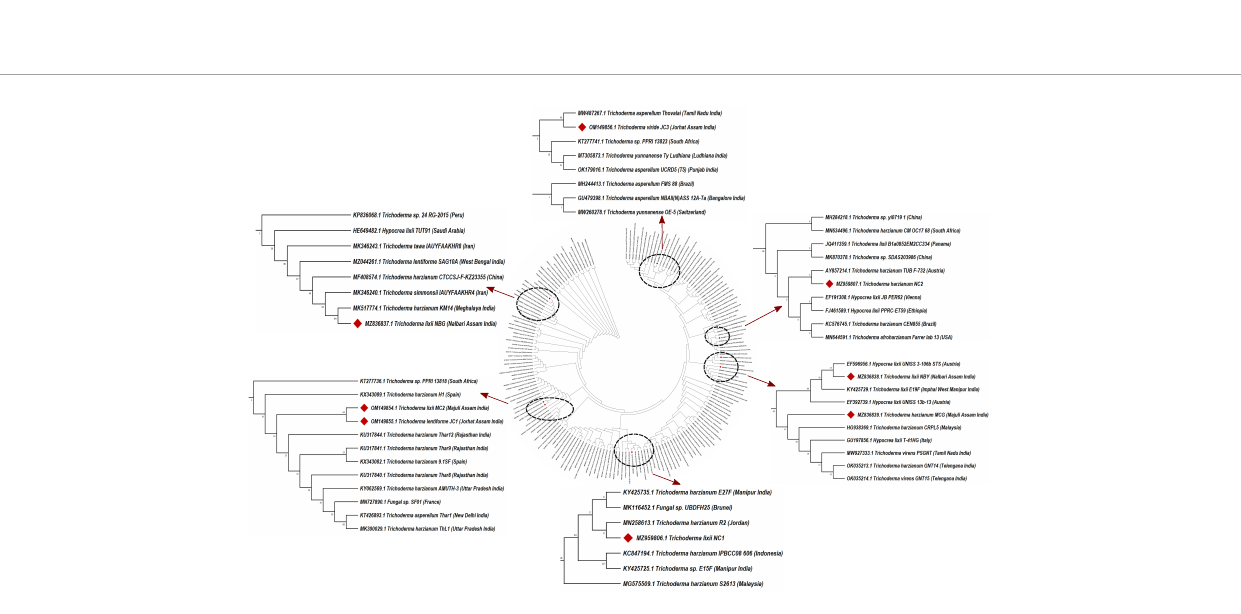
FIGURE 3 Phylogenetic tree of representative isolates of Trichoderma spp. inferred by Maximum Parsimony analysis of ITS1, 5.8s and ITS2 sequences in MEGA X11. The bootstrap support from 500 replications is indicated on the